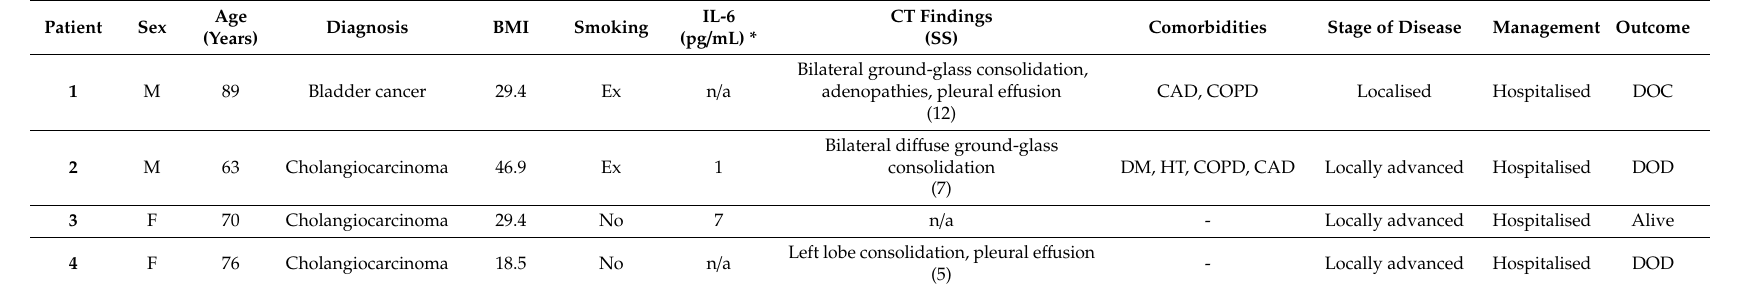
Table 4. Clinical characteristics of COVID-19 patients recently diagnosed with cancer